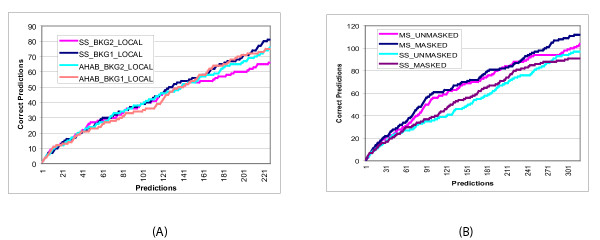
(a) Comparison between Ahab and Stubb, local background of orders 1 and 2 in different runs. All runs are on D. melanogaster genome only. (b) Effect of tandem repeat masking of input sequences. "MS_MASKED" and "MS_UNMASKED": STUBBMS, with global background model of order 2, on masked and unmasked sequence respectively. "SS_MASKED" and "SS_UNMASKED": STUBBSS, with local background model of order 1, on masked and unmasked sequence respectively.